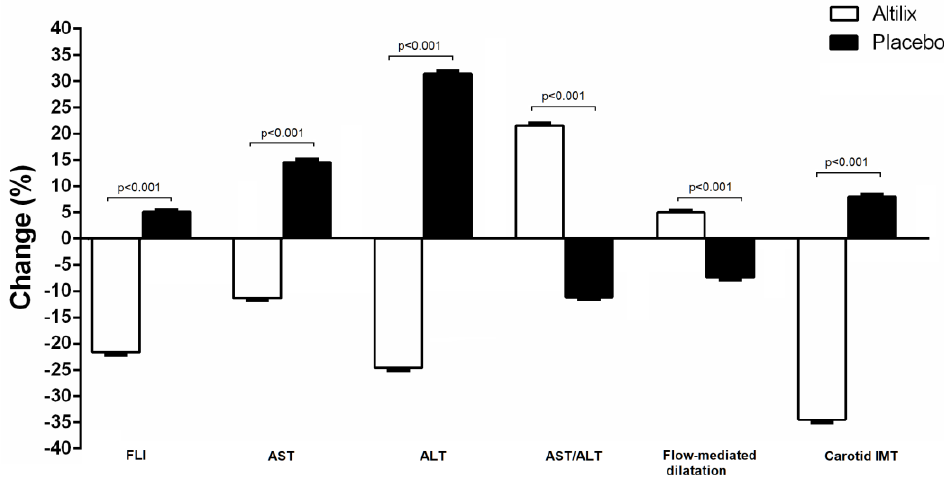
Figure 3 . Percentage changes of liver and cardiovascular parameters in all subjects. Figure 3. Percentage changes of liver and cardiovascular parameters in all